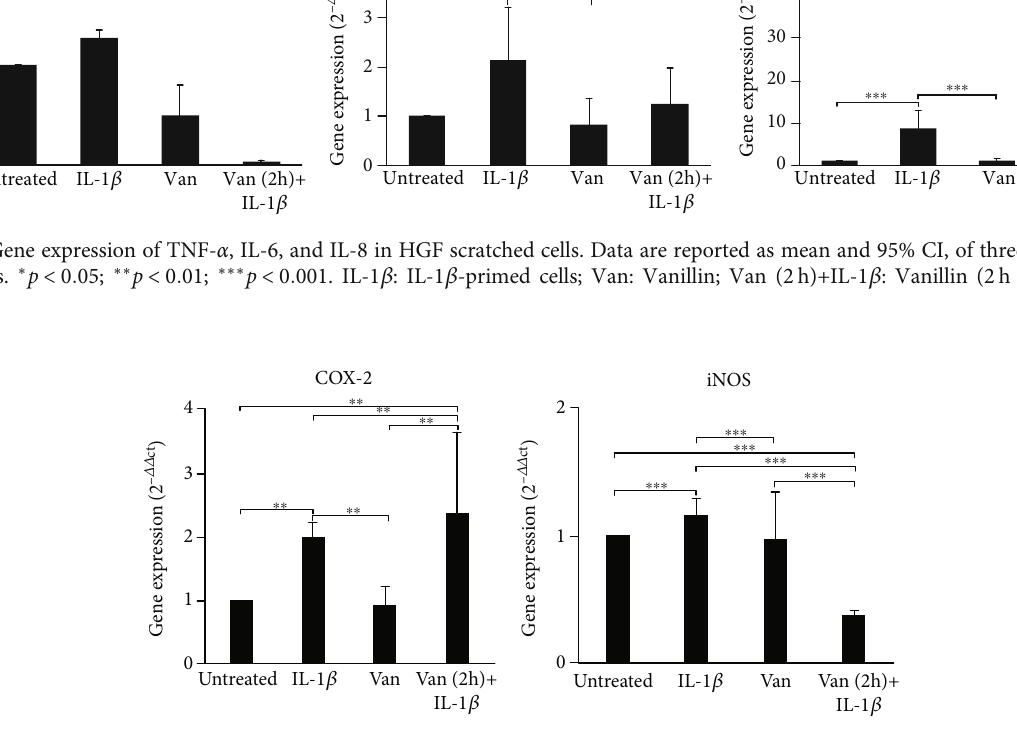
Figure 9: Gene expression of COX-2 and iNOS in HGF cells. Data are reported as mean and 95% CI, of three independent experiments. ∗∗ p < 0 : 01 ; ∗∗∗ p < 0 : 001 . IL-1 β : IL-1 β -primed cells; Van: Vanillin; Van (2 h)+IL-1 β : Vanillin (2 h pretreatment) plus IL-1 β .